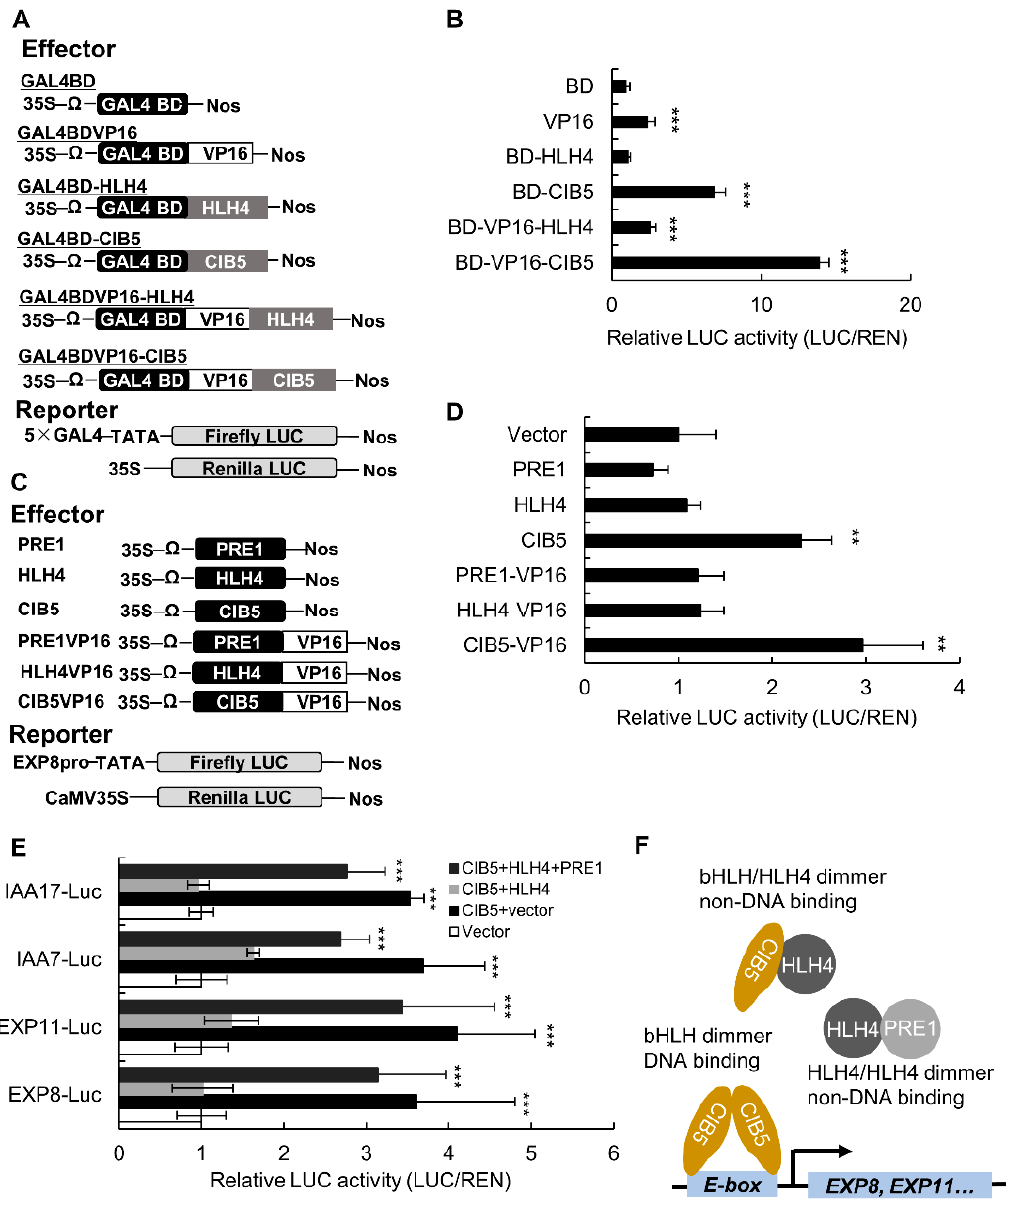
Figure 6. HLH4 forms a triantagonistic complex with CIB5 and PRE1 to repress target gene expression. ( A ) Schematic representation of the constructs used in the transient expression assay. The pro35S-GAL4-LUC reporter construct (5 × Gal4-LUC) harbors a firefly luciferase (LUC) coding sequence driven by the CaMV 35S promoter with five copies of the GAL4-responsive element;proAtUbiquitin3:REN (Renilla LUC) served as an internal control. HLH4, PRE1 and CIB5 coding sequences fused to the GAL4 DNA binding domain (BD) or VP16 activation domain driven by the CaMV 35S promoter were used as effector constructs. ( B ) Relative luciferase activities detected in A. thaliana protoplasts transformed with the plasmids shown in ( A ). The luciferase activity of the empty vector with the BD coding sequence was set as 1. ( C ) Schematic representation of the constructs used in transient expression analysis; proEXP8-LUC reporter gene contains a LUC coding sequence driven by 2 kb EXP8 promoter and the effector constructs contain the protein-coding region of